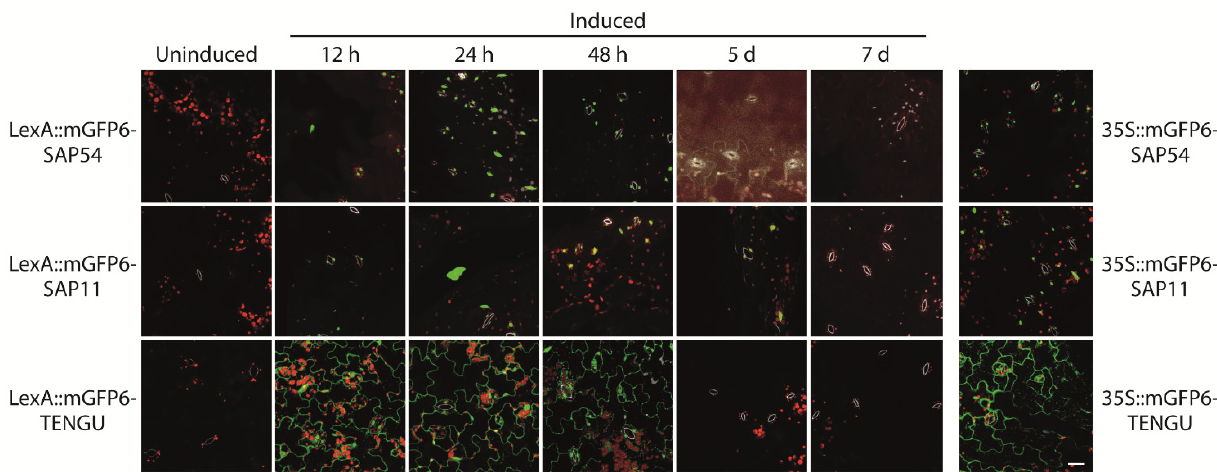
Figure 3. Time course of mGFP6-SAP54, mGFP6-SAP11, and mGFP6-TENGU fusion protein expression after induction. 2-week-old Arabidopsis LexA::mGFP6-SAP54, LexA::mGFP6-SAP11, and LexA::mGFP6-TENGU plants grown on NM were transferred to IM and fluorescence signals were recorded after 12 h, 24 h, 48 h, 5 d, and 7 d. For comparison fluorescence signals of plants constitutively expressing mGFP6-SAP54, mGFP6-SAP11 and mGFP6-TENGU, respectively under control of the CaMV-35S promotor are shown. Pictures were taken at X400 magnification at an excitation wavelength of 488 nm and emission spectra were recorded for GFP fluorescence (green), chlorophyll autofluorescence (red) and autofluorescence of strengthened cell walls of stomata (white) separately. Scale bar corresponds to 100 µm.